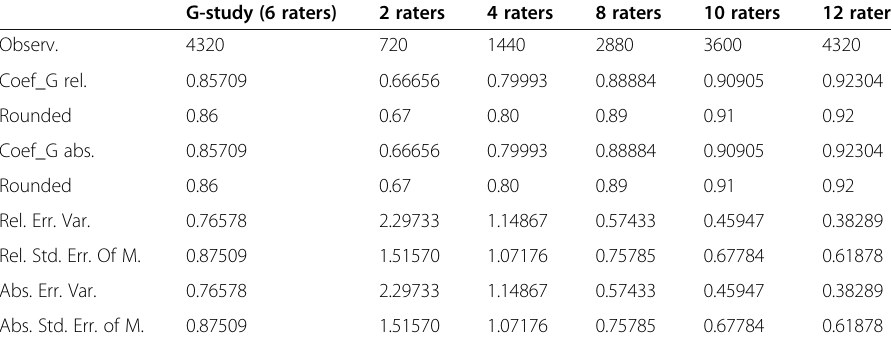
Table 9 D-study (rater) G-study (6 raters) 2 raters 4 raters 8 raters 10 raters 12 raters Observ. 4320 720 1440 2880 3600 4320 Coef_G rel. 0.85709 0.66656 0.79993 0.88884 0.90905 0.92304 Rounded 0.86 0.67 0.80 0.89 0.91 0.92 Coef_G abs. 0.85709 0.66656 0.79993 0.88884 0.90905 0.92304 Rounded 0.86 0.67 0.80 0.89 0.91 0.92 Rel. Err. Var. 0.76578 2.29733 1.14867 0.57433 0.45947 0.38289 Rel. Std. Err. Of M. 0.87509 1.51570 1.07176 0.75785 0.67784 0.61878 Abs. Err. Var. 0.76578 2.29733 1.14867 0.57433 0.45947 0.38289 Abs. Std. Err. of M. 0.87509 1.51570 1.07176 0.75785 0.67784